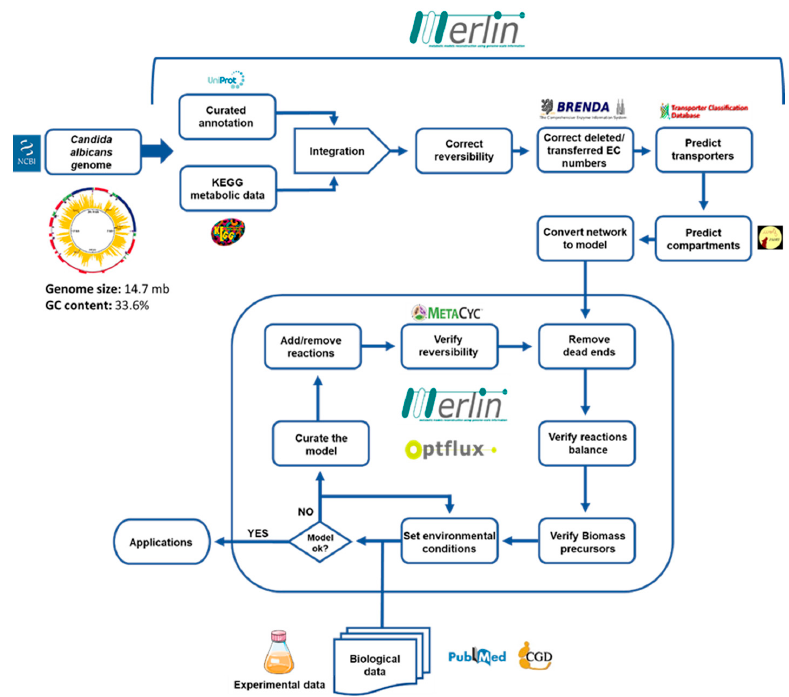
Figure 1. Methodology for the reconstruction of the Candida albicans iRV781 metabolic model. Adapted from [14].